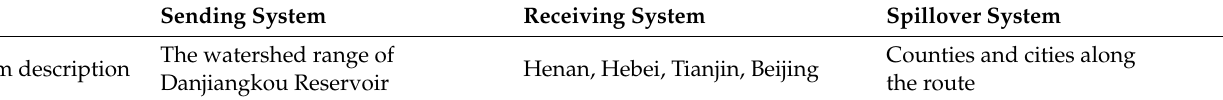
Table 3. Telecoupling of